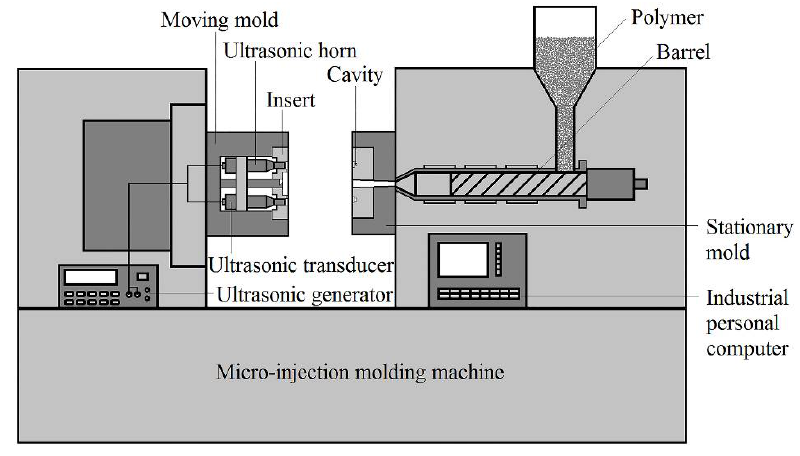
Figure 1. The schematic diagram of LUμIM system.